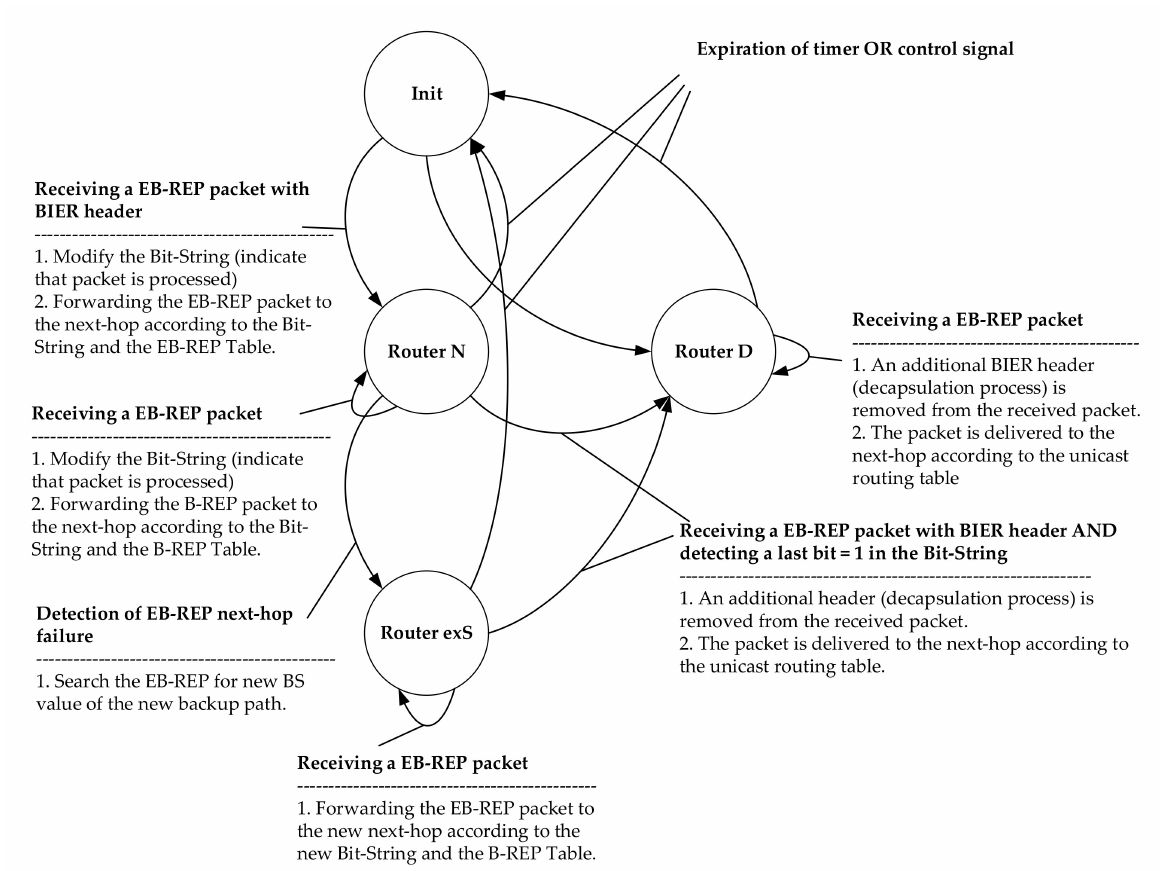
Figure 11. The EB-REP state diagram for D and N routers.